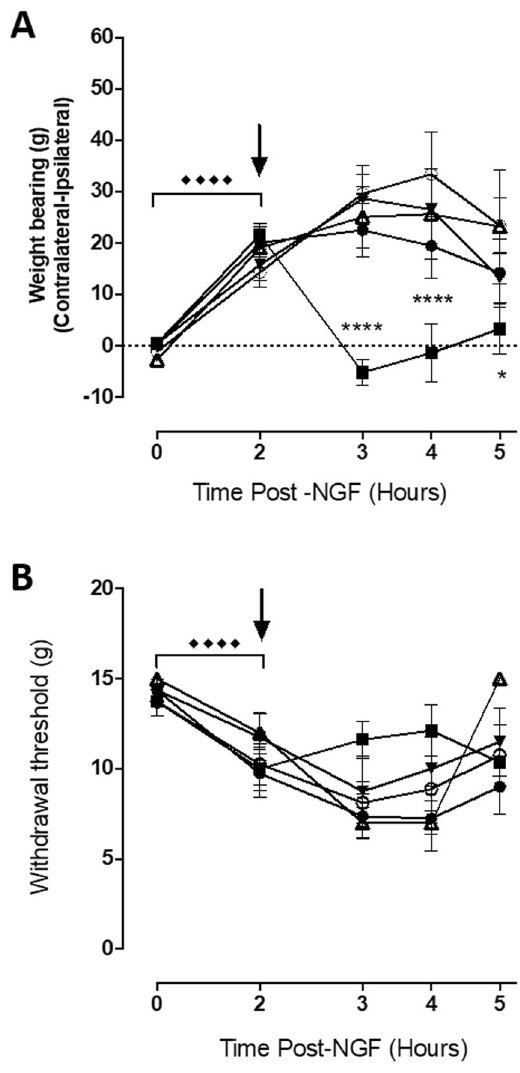
Figure 1. Intra-articular inactivation of TRPV1 expressing nociceptors reverses NGF induced pain. Intra- articular NGF (10 μ g/50 μ l) produced significant WB asymmetry ( A ) and reductions in PWTs ( B ) at 2 hours post-injection. Subsequent injection (indicated by the black arrow) of membrane impermeable local anaesthetic QX-314 alone ( ● ) did not alter NGF-induced pain behaviour. Concomitant injection of QX-314 (1 mg/50 μ l) with capsaicin (1 μ g per μ l) ( ■ )significantly reversed WB asymmetry up to 2 hours post-injection ( A ), but had no effect on PWTs ( B ). ● = QX-314, ■ = QX314 + capsaicin, Δ = capsaicin, ▲ = lidocaine, ○ = vehicle. Changes in PWT or WB following NGF injection were performed using a 2-way ANOVA (treatment x time) with Dunnett’s multiple comparison test comparing WB and PWT to the measurement. ◆◆◆◆ < 0.0001 (time 0 vs 2hrs post NGF). * p < 0.05, ** p < 0.01, *** p < 0.001, **** p < 0.0001 (Dunnett’s; 2hrs postNGF vs pharmacological intervention)). All data are presented as mean ±